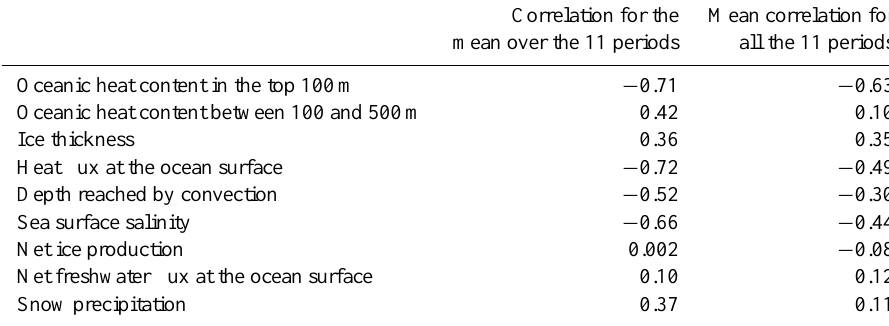
Table 1. Correlation between ice concentration trend and other model variables. Correlation for the Mean correlation for mean over the 11 periods all the 11 periods Oceanic heat content in the top 100m − 0.71 − 0.63 Oceanic heat content between 100 and 500m 0.42 0.10 Ice thickness 0.36 0.35 Heat flux at the ocean surface − 0.72 − 0.49 Depth reached by convection − 0.52 − 0.30 Sea surface salinity − 0.66 − 0.44 0.002 − 0.08 0.10 0.12 0.37 0.11